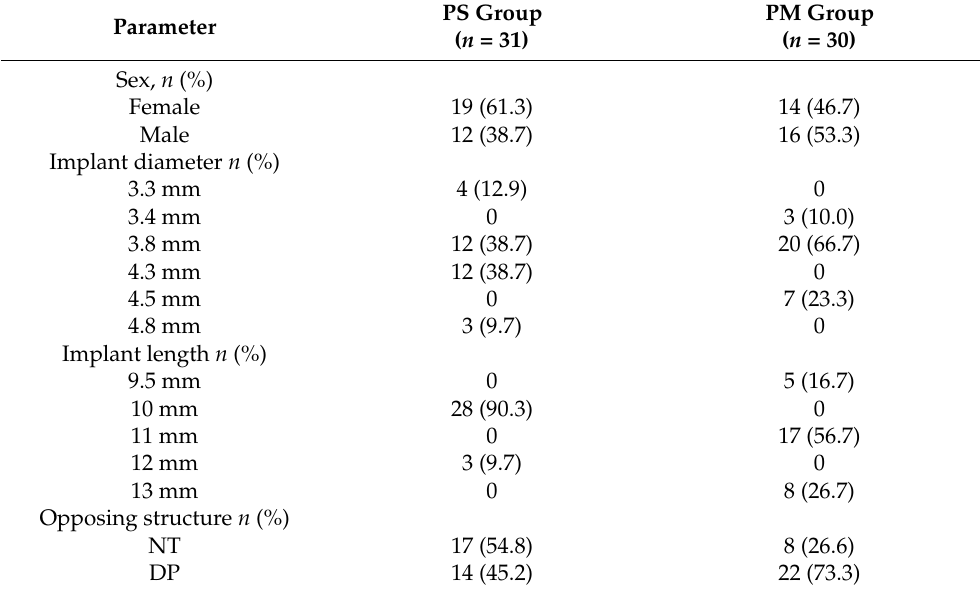
Table 1. Demographic parameters of the study